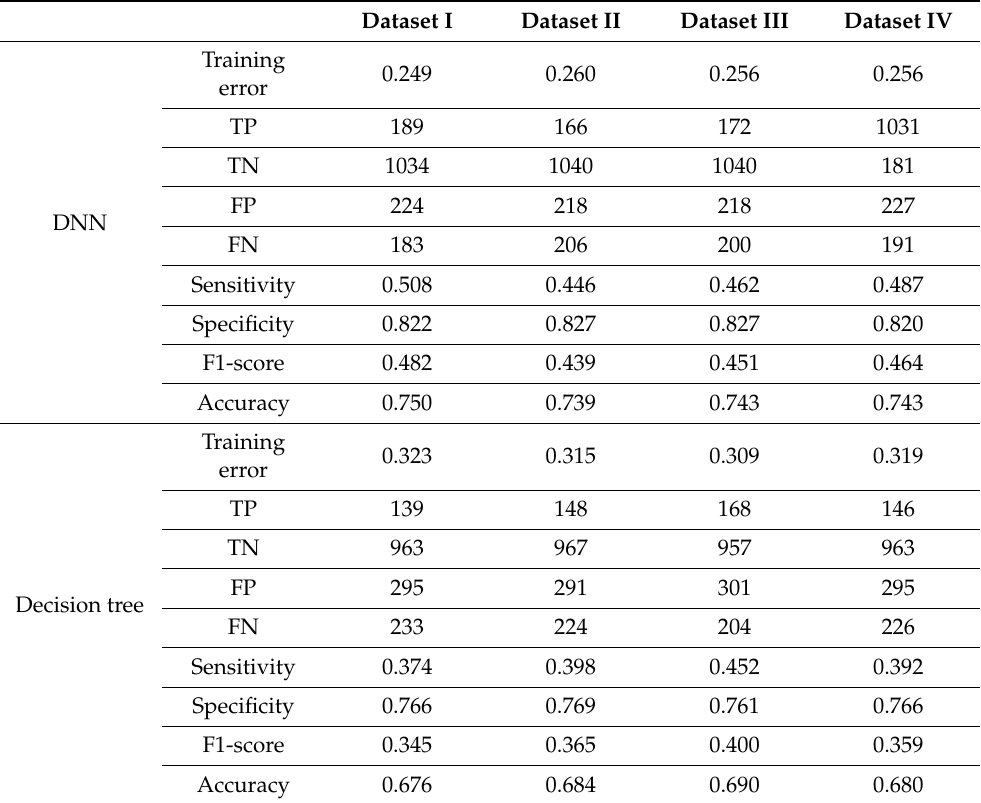
Table 8. Performance comparison of DNN and decision tree according to the dataset. Dataset